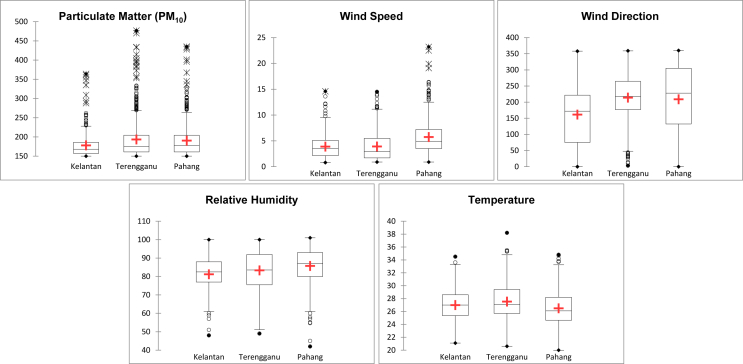
A decadal analysis (box plot) based on the hazy period for particulate matter and meteorology dataset.